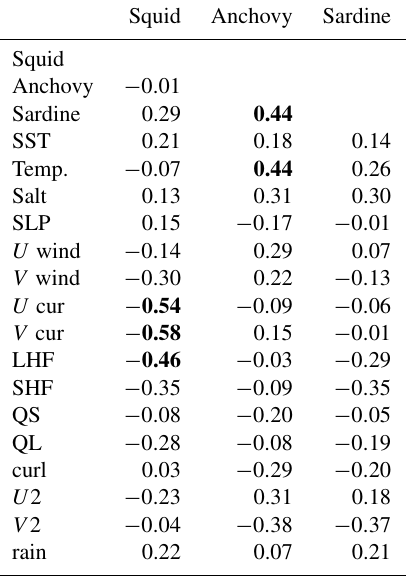
Table 2. Pairwise correlations of annual fish catch in the outer do- main (see Fig. 8) and January–June marine data averaged over the index area, 1981–2015. N = 35 at 1 year resolution; significant val- ues are bold. Variables are the same as in Table 1, except Temp. is sea temperature at 10m depth and U 2 and V 2 wind are the upper- level wind components (200hPa) from MERRA2. SST is derived from NOAA, rainfall is from CHIRPS2, and other variables are from